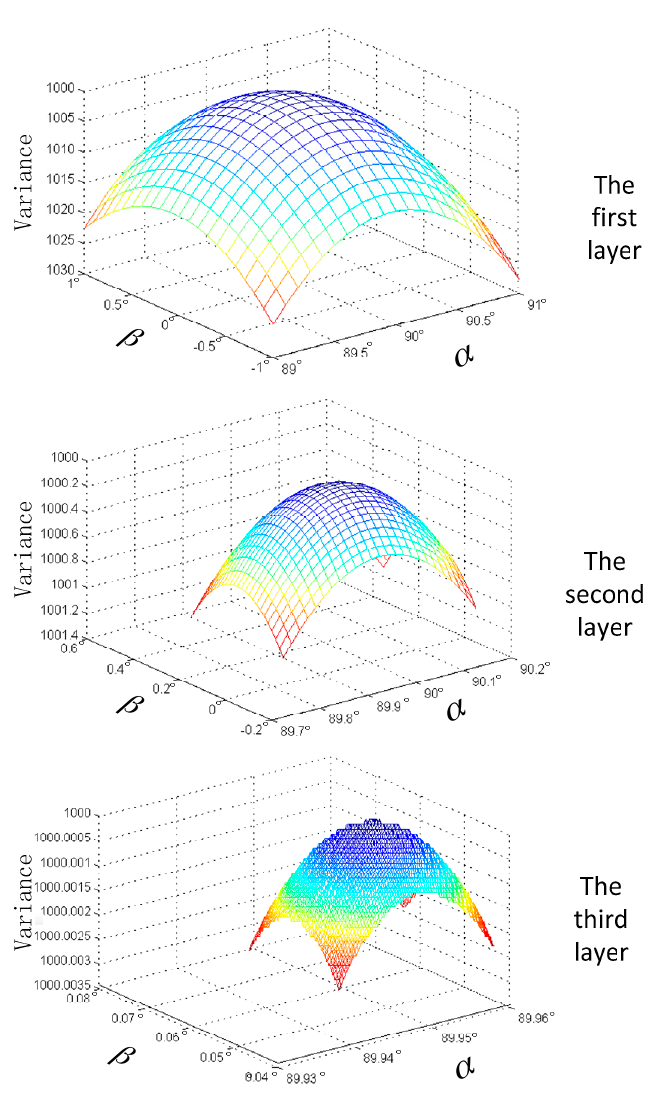
Figure 6. Pointing angle prediction.